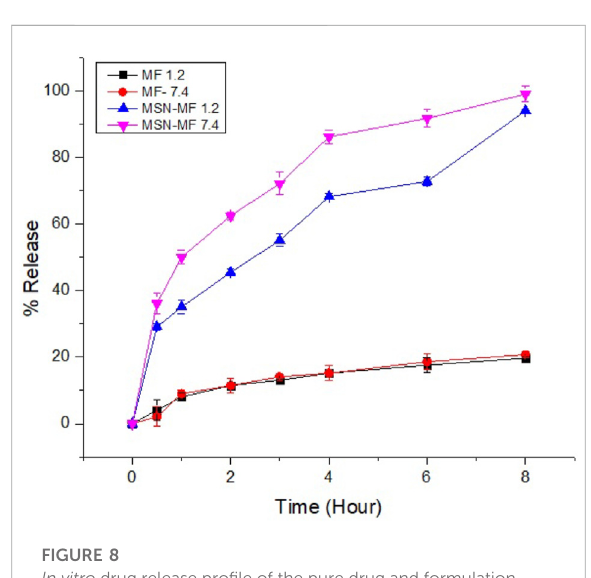
FIGURE 8 In vitro drug release pro fi le of the pure drug and